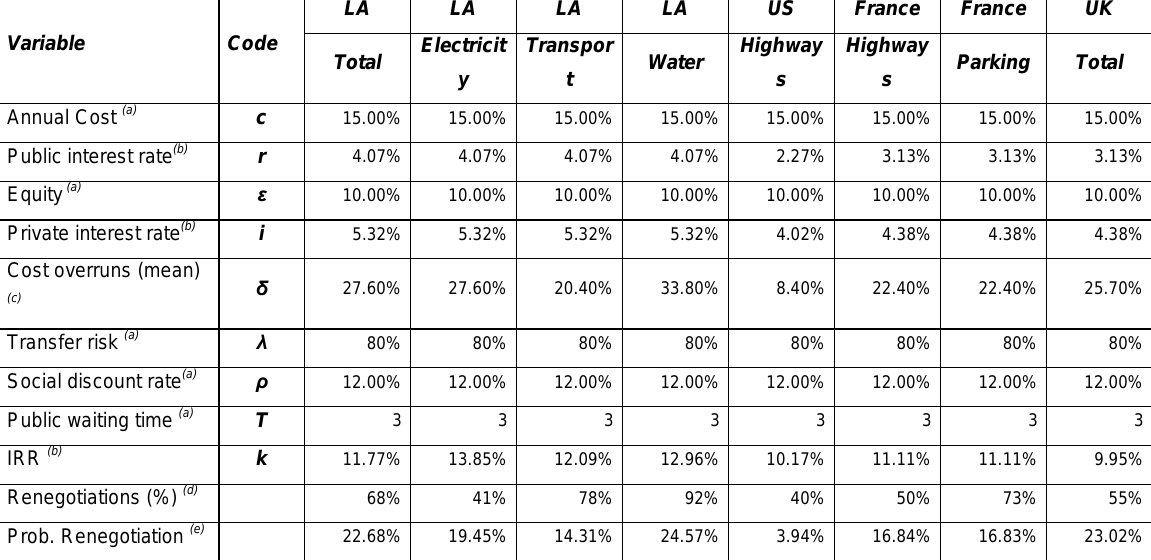
LA LA LA LA US France France UK Electricit Transpor Highway Highway Total Water Parking Total y t s s